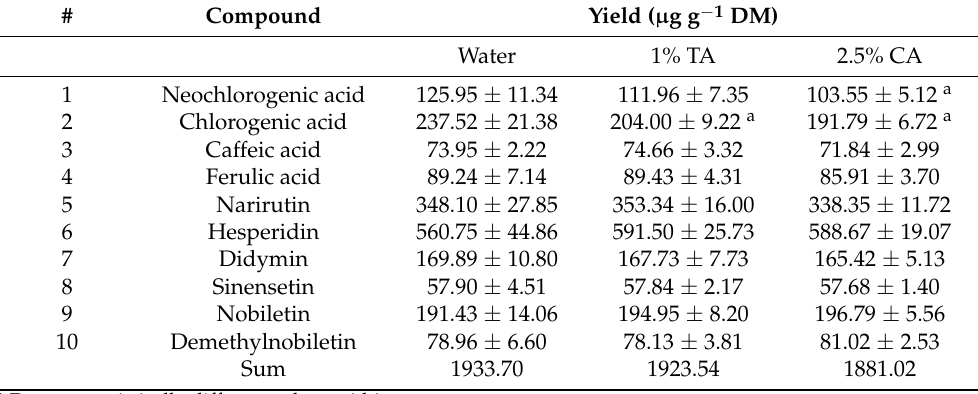
Table 3. The quantitative data on the polyphenolic composition of WOP extracts. TA and CA denote tartaric and citric acid, respectively. The values given represent means of triplicate determination ± standard deviation.